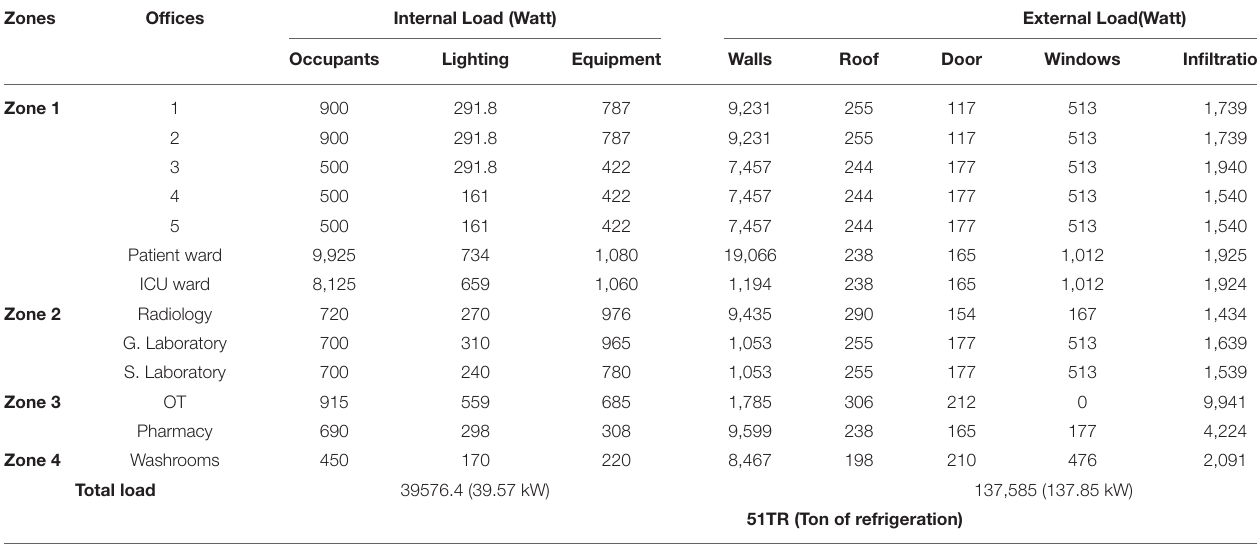
TABLE 2 | Estimated thermal load for each zone in the